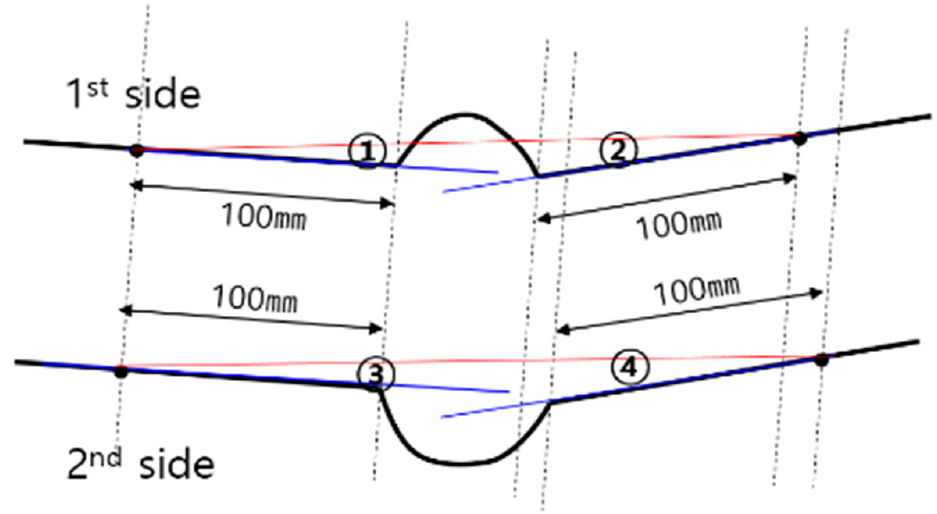
Figure 16. Schematic diagram of the angular distortion measurement.